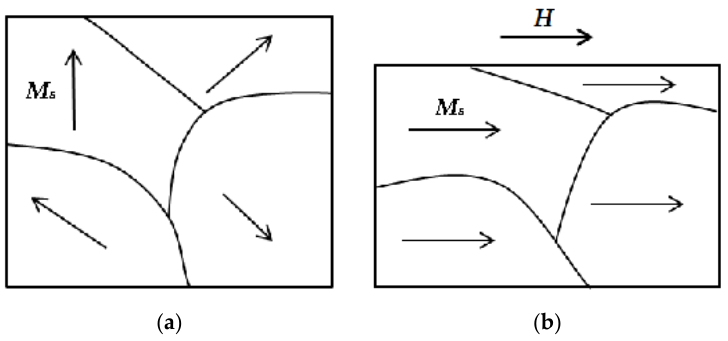
Figure 8. Evolution of magnetic domains: ( a ) before and ( b ) after applying a magnetic field. When an external magnetic field is applied, the directions of M s in different magnetic domains become ordered and the ferromagnetic material is then magnetized (Figure 8b). Here, H represents the magnetic field intensity. Then magnetization intensity δ𝑀 𝐻 along the direction of the external magnetic field can be expressed as follows